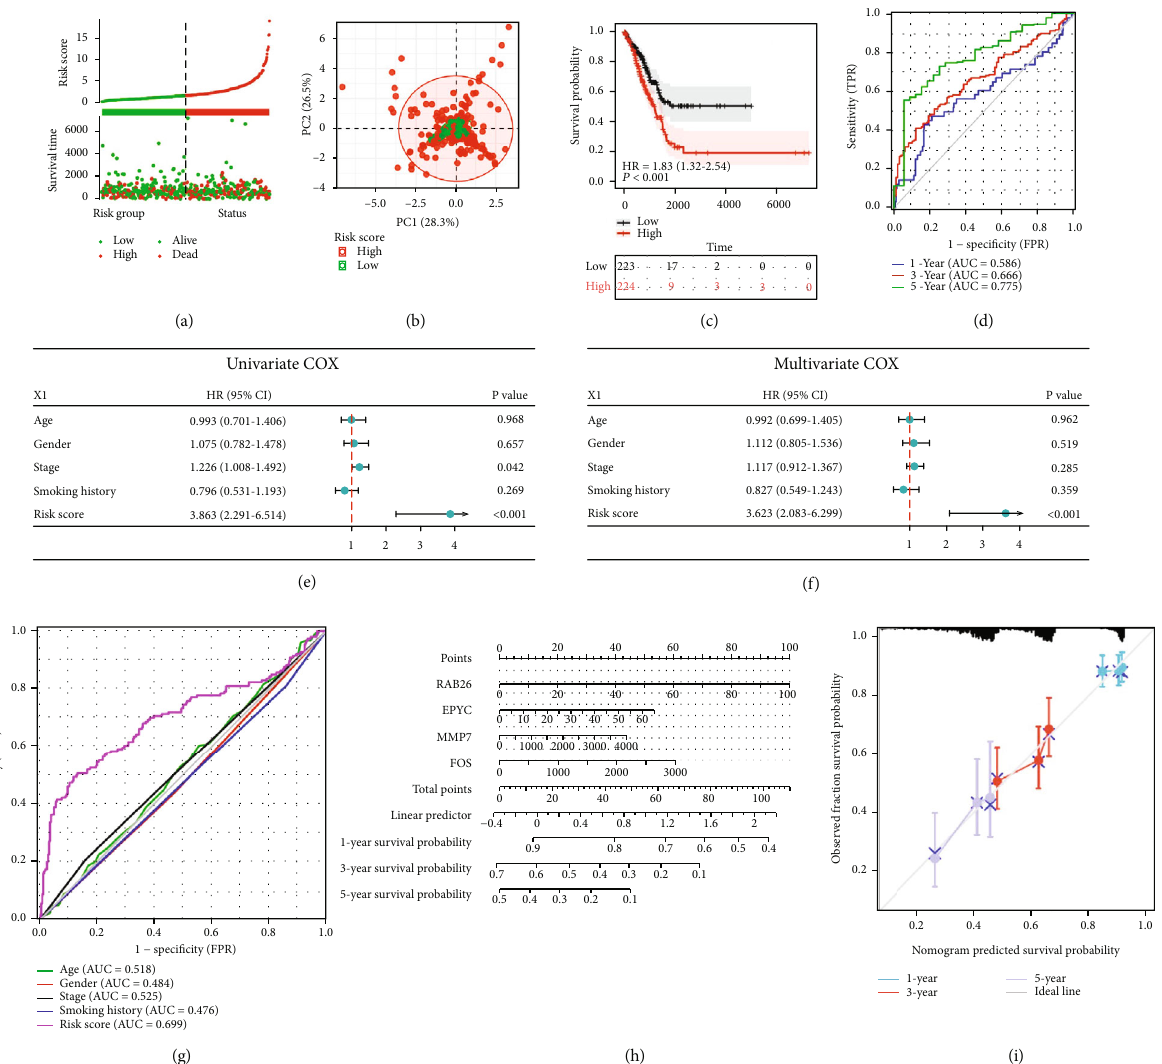
Figure 4: Evaluation of the CTCR model in TCGA-LUAD cohort (n =447). (a) Survival status and risk scores in the training cohort. (b) PCA analysis of grouped samples in the training cohort. (c) KM curves demonstrating longer OS in the low-risk group. (d) AUC values of time-dependent ROC curves verify the predictive accuracy of the risk score. (E, F) Univariate and multivariate Cox analyses were performed to examine the correlation among clinical features, risk scores and OS. (G) Comparison of ROC curves among patients with di ff erent clinical characteristics, such as age, sex and stage, and risk scores in the training cohort. (H) Nomogram based on the 4 CTC- related genes quantitatively predicts the survival of patients with LUAD. (i) Calibration plot for internal validation of the